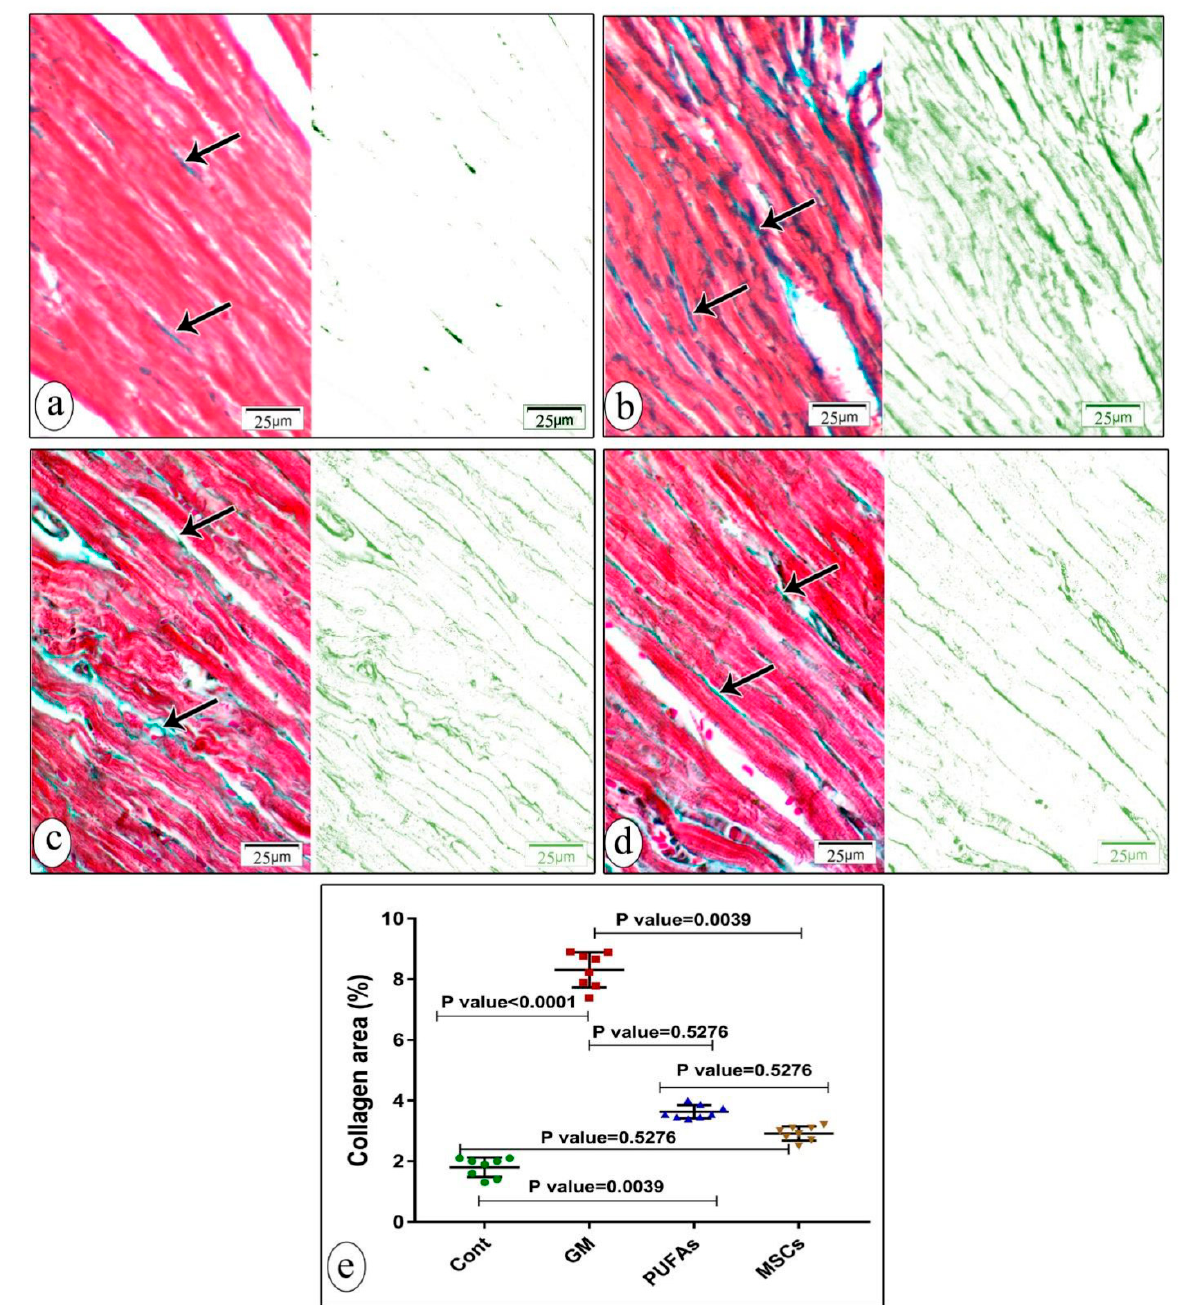
showing regularly arranged cardiac myofibers with oval, rounded nuclei (arrow). Note that inset images of higher magnification were added in all panels photos to show the nucleus.